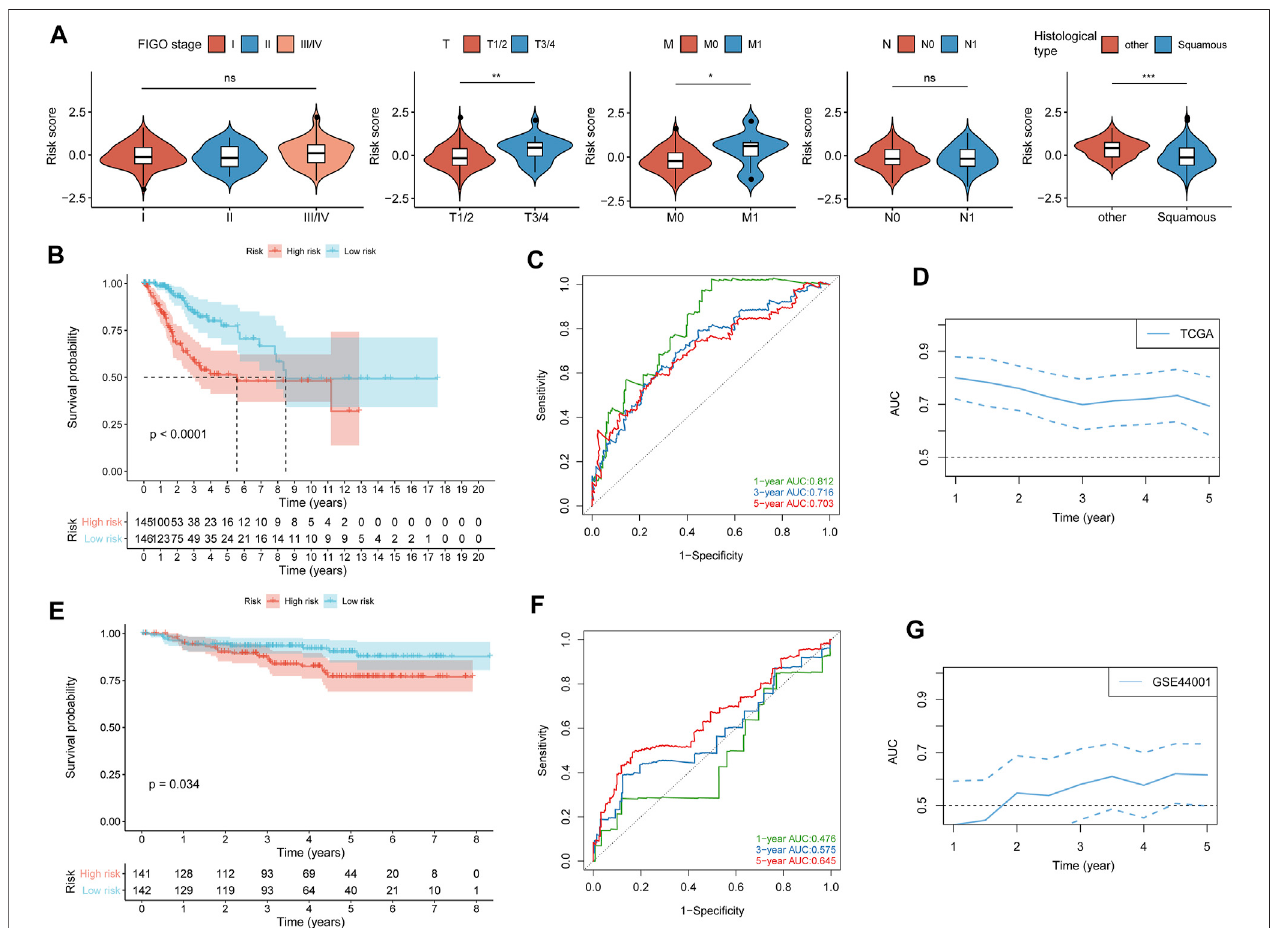
FIGURE 2 | Validation of the prognostic value of the risk score. (A) Difference analysis of the distribution of risk scores in different FIGO stages, TNM stages, and histological types. (B) Kaplan – Meier curves for differential detection ofpatientsin the TCGA cohort by thelog-ranktest. (C) ROCcurvesofriskscoresused to predict 1- year, 3-year, and 5-year survival in the TCGA cohort. (D) Time-dependent ROC curves of the risk score in the TCGA cohorts. (E) Kaplan – Meier curves for differential detection of patients in the GSE44001 cohort by the log-rank test. (F) ROC curves of risk scores used to predict 1-year, 3-year, and 5-year survival in the GSE44001 cohort. (G) Time-dependent ROC curves of the risk score in the GSE44001 cohorts. * p < 0.05; ** p < 0.01; *** p < 0.001; ns, not signi fi cant.